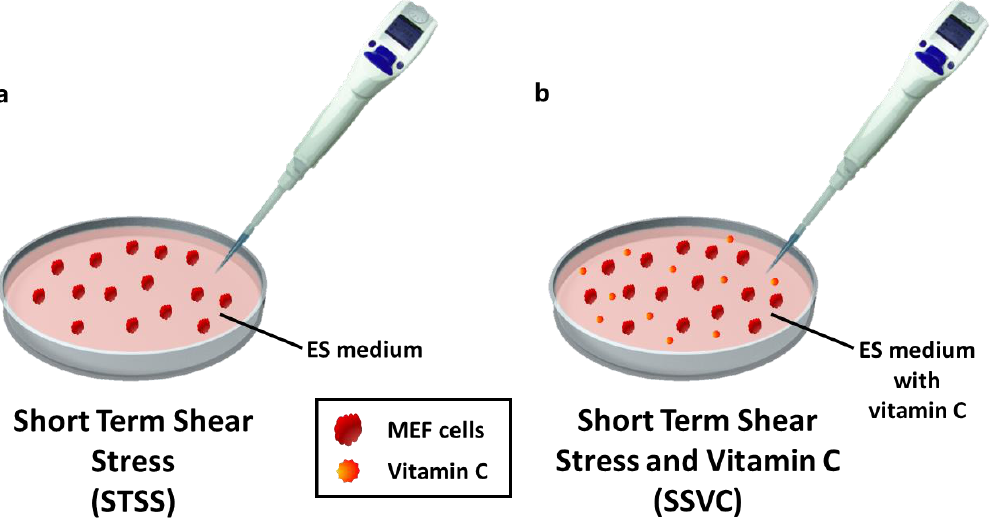
Figure 1. The schematic diagram for induction method of pluripotent stem cell-like cells. ( a ) Short-term shear stress method (STSS). ( b ) Short-term shear stress and vitamin C method (SSVC).